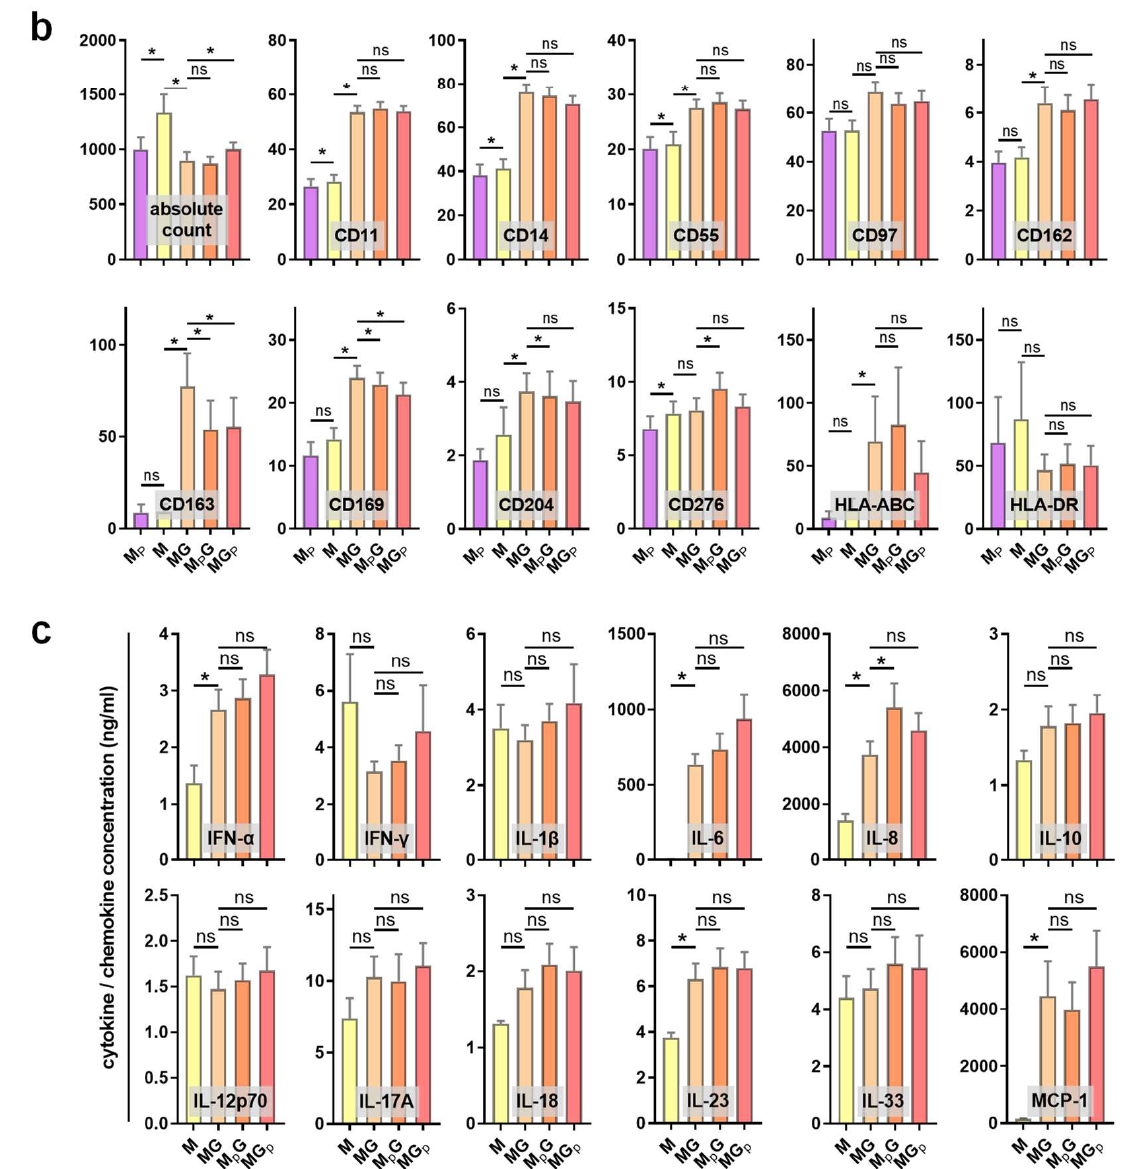
Figure 2. Monocyte surface marker expression and cytokine release profiles in GBM